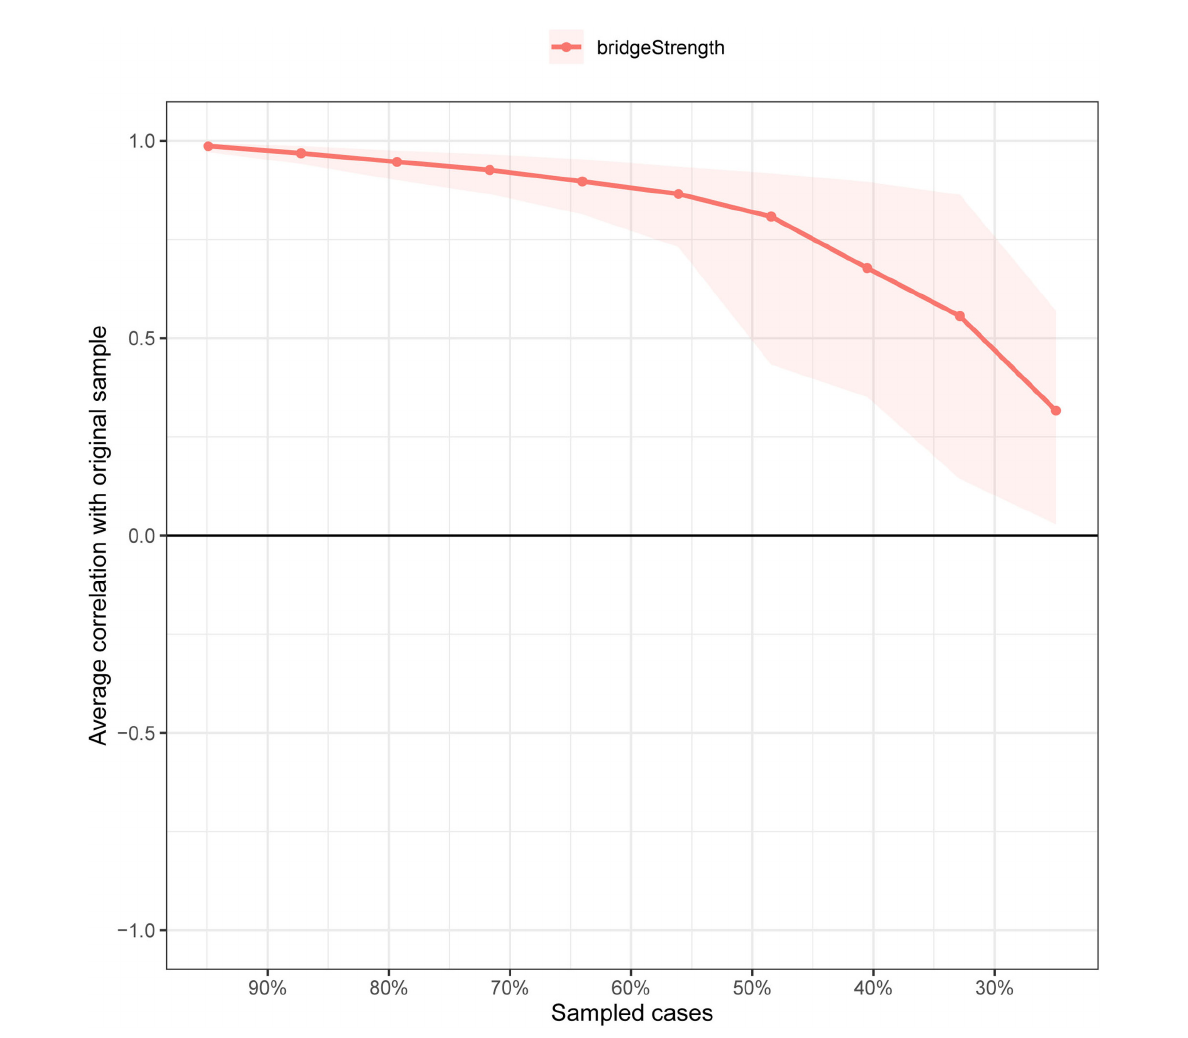
FIGURE3 Evaluation of the stability of strength centrality. The red bar represents the average correlation between centrality indices in the full sample and subsample with the red area depicting the 2.5th quantile to the 97.5th